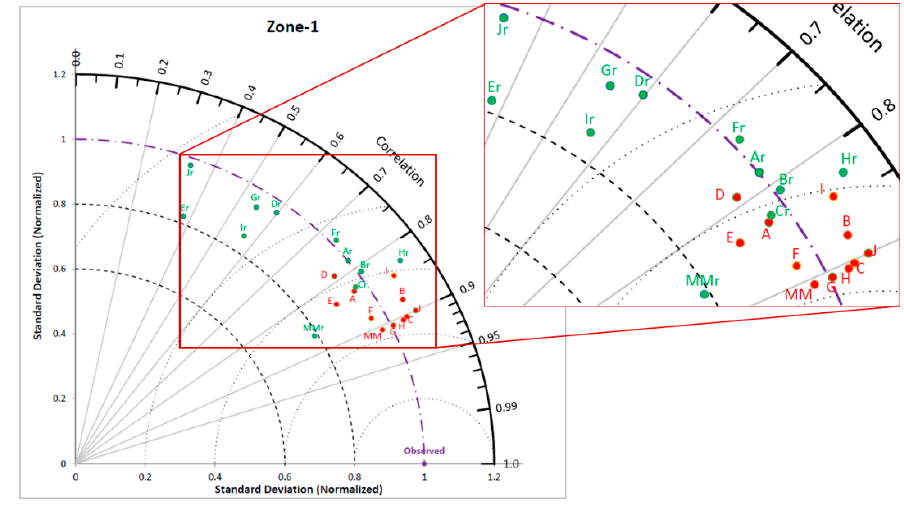
Figure 8. Taylor diagram for comparison of downscaling performances by Re-Obs and GCM-Obs methods for zone 1. Notations A to J and MM are used for different GCMs and Multi-model ensemble average (A—CMCC-CESM, B—CMCC-CM, C—CMCC-CMS, D—FGOALS-g2, E—FGOALS-s2, F—GFDL-CM3, G—HadGEM-AO, H—INMCM4, I—MIROC-ESM, J—MIROC-ESM-CHEM, MM—Multi-model ensemble average). Notations with subscript ‘r’ and that is green coloured are used for defining downscaling with the Re-Obs model. Downscaling with the GCM-Obs model is shown in red and with no subscript in notations.